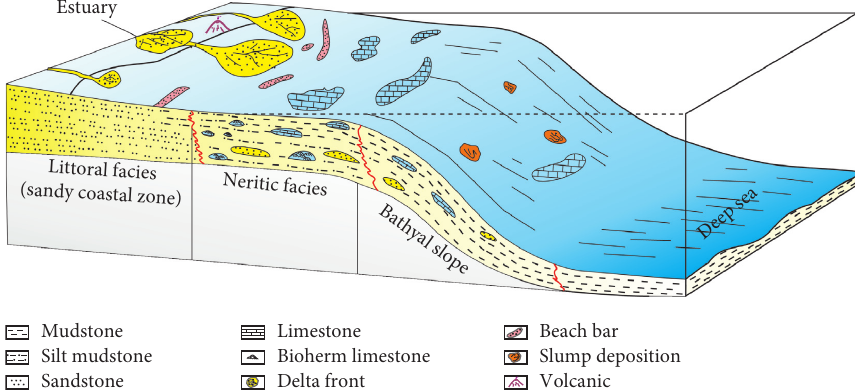
Figure 10: Sedimentary model of the Late Permian Linxi Formation in the Linxi area of eastern Inner